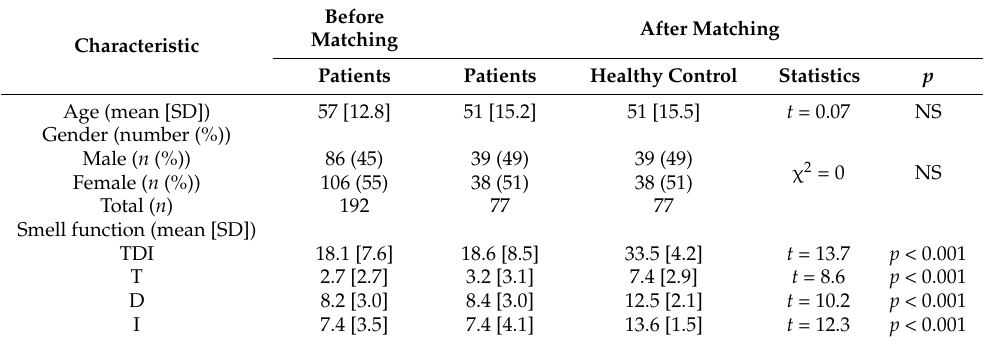
Table 1. Demographic characteristics of patients, results from olfactory